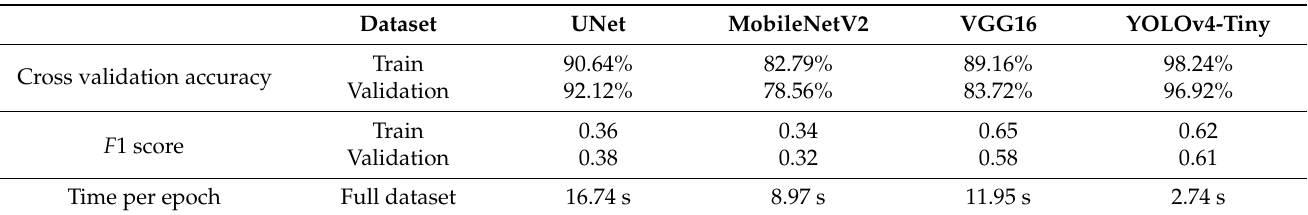
Table 1. Neural network learning